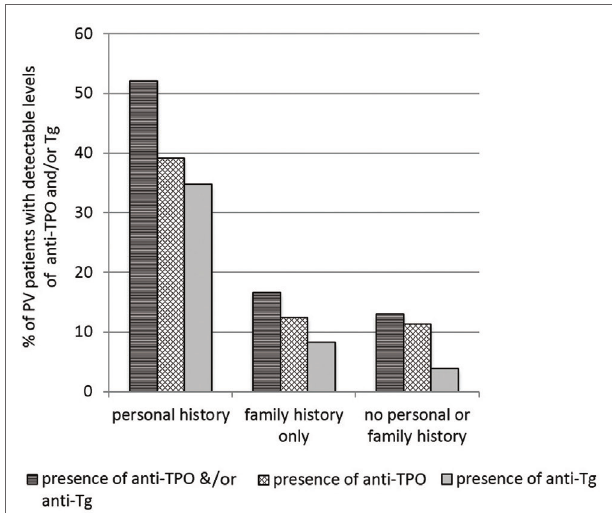
FigUre 1 | Levels of anti-thyroid peroxidase (anti-TPO) and or anti- thyroglobulin (anti-Tg) by self-reported presence of personal or family history of autoimmune thyroid disease (AITD) in pemphigus vulgaris (PV) patients. Bars represent the percentage of PV patients that have detectable levels of anti-TPO or anti-Tg in subgroups divided by personal and family history of